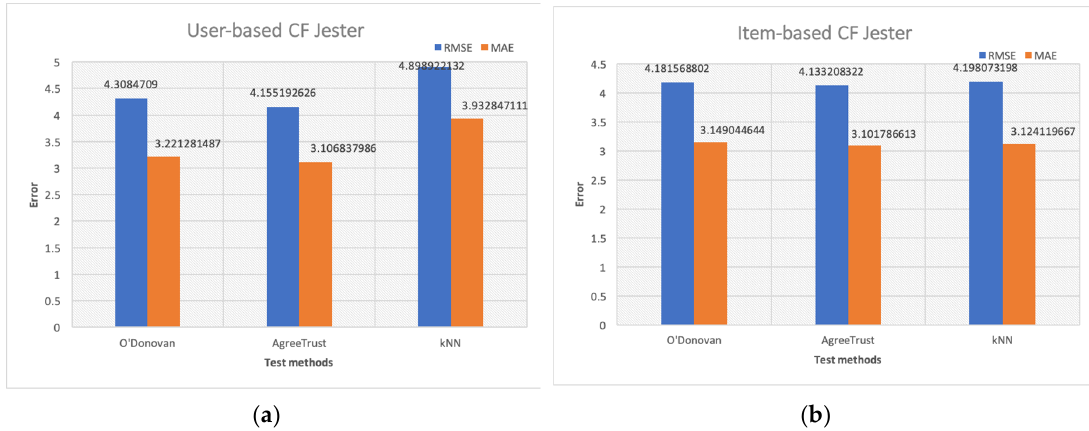
( b ) Figure 1. Result of three collaborative filtering (CF) methods for the ML-20m dataset: ( a ) user-based and ( b ) item-based. RMSE—root mean square error; MAE—mean absolute error; kNN—k-nearest neighbor. Regarding the prediction accuracy, for user-based CF, AgreeRelTrust outperformed all other methods. It achieved a marginal improvement of 0.42% in RMSE against the baseline (O’Donovan) and significantly against kNN by 7.56%. For the MAE, the respective improvements were 0.52% and 8.2%. Similarly, O’Donovan displayed improved accuracy of RMSE by 7.2% and MAE by 7.76%. With respect to the accuracy for item-based CF, AgreeRelTrust ranked first. It exhibited improvements in RMSE ranging from 9.11% (against kNN) to 1.6% (against O’Donovan), and the corresponding improvements in MAE are 10.4% (against kNN) and 1.7% (against O’Donovan). O’Donovan, which ranked second, outperformed kNN in RMSE by 7.7% and in MAE by 8.9%. Both trust-based methods, AgreeRelTrust and O’Donovan, have better accuracy for item-based